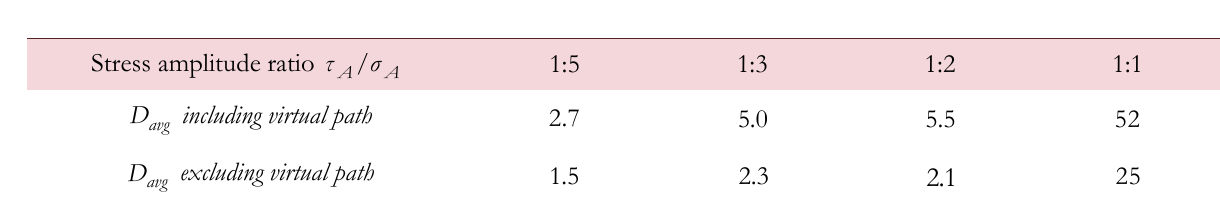
Table 7a: Average fatigue damage obtained with PDMR cycle counting for VA loading considering different stress amplitude ratios; Results normalized with pure tension/bending (i.e. normal stress only).